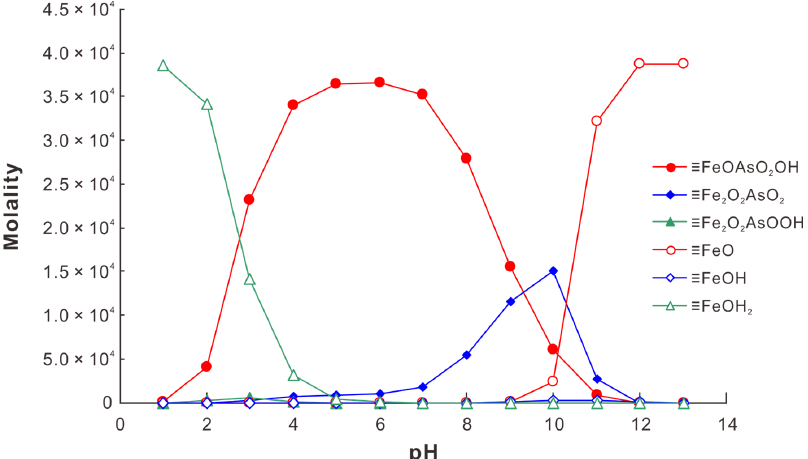
Figure 13. Speciation distribution of surface complexation on PC ‐ Fe/C ‐ B, after As(V) adsorption (initial As = 20 mg/L). (initial As = 20